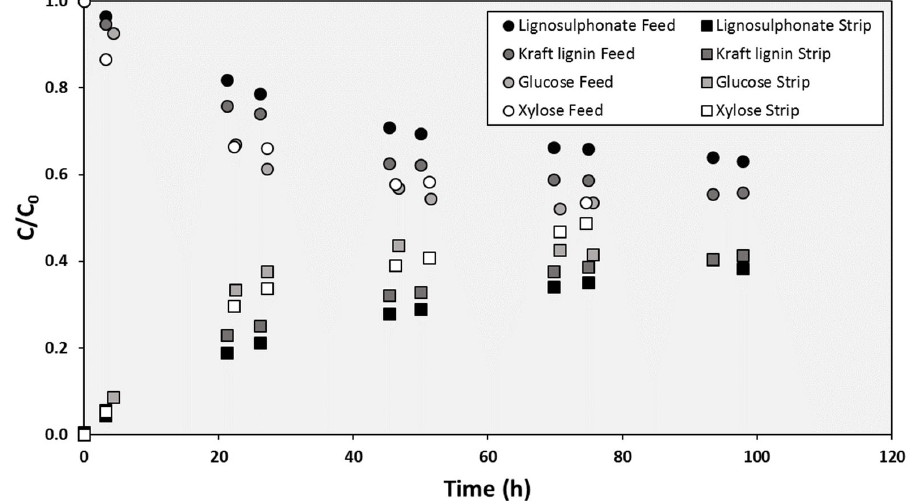
Figure 1. Evolution of the concentration of the di ff erent solutes in the cell compartments during a typical SILM